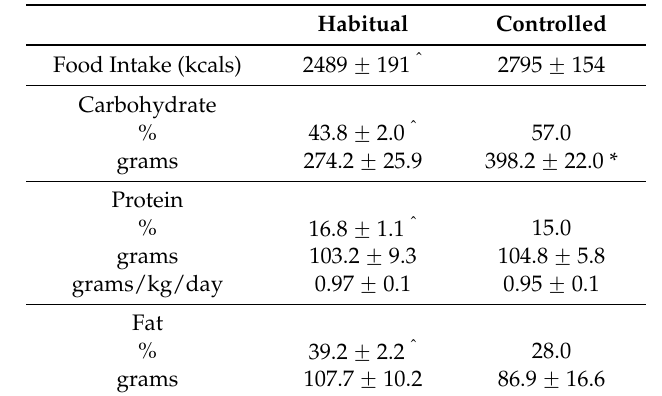
Table 2. Dietary